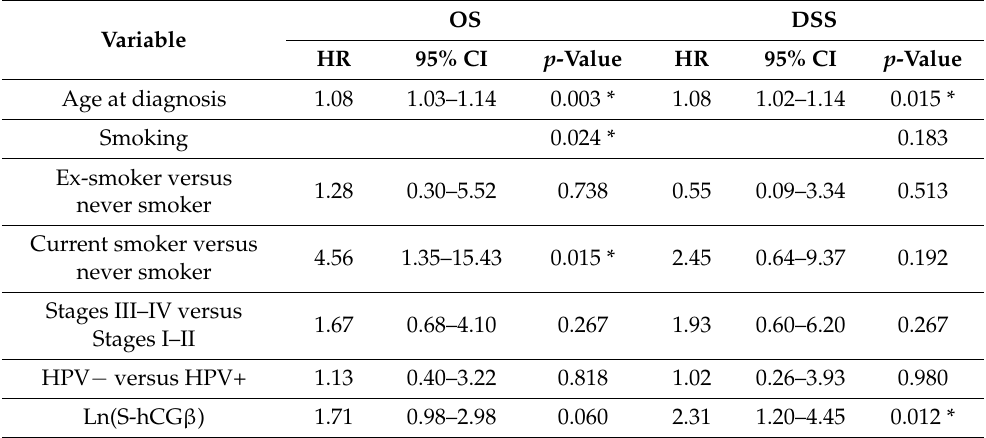
Table 2. Multivariate Cox regression analysis for overall survival (OS) and disease-specific survival